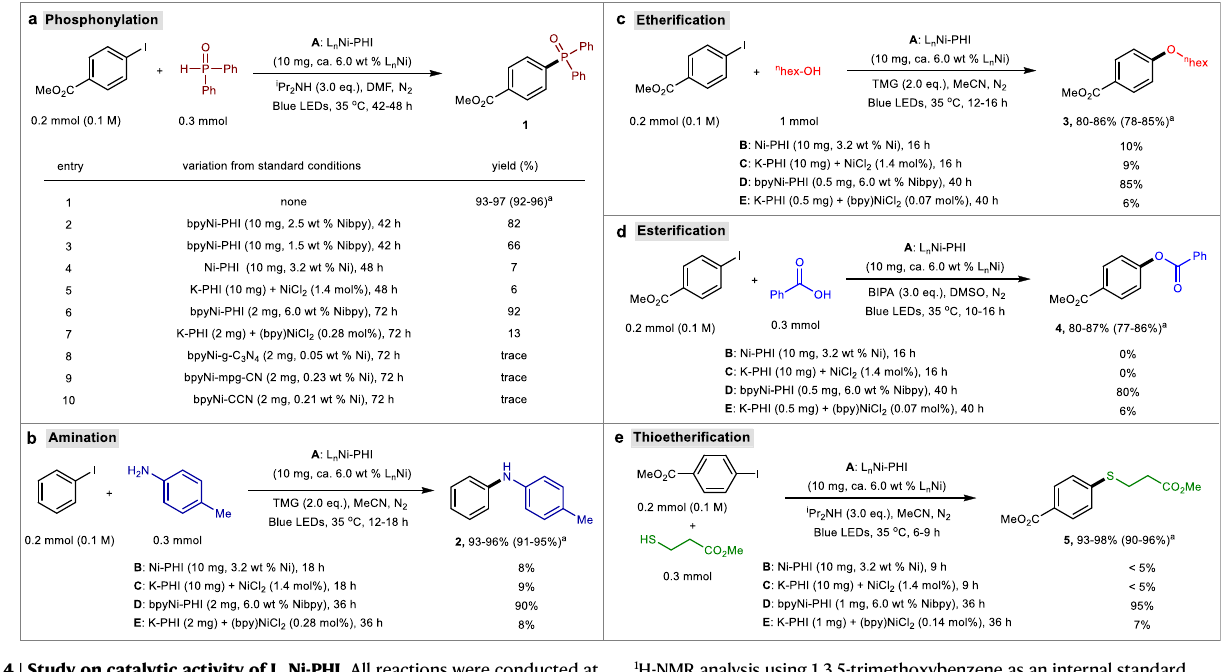
Fig. 4 | Study on catalytic activity of L n Ni-PHI. All reactions were conducted at 0.2mmol scale under N 2 atmosphere and blue LEDs irradiation (24W, 460±5nm) without extra heating (at 35±5°C). Yields of products 1 – 5 were determined by